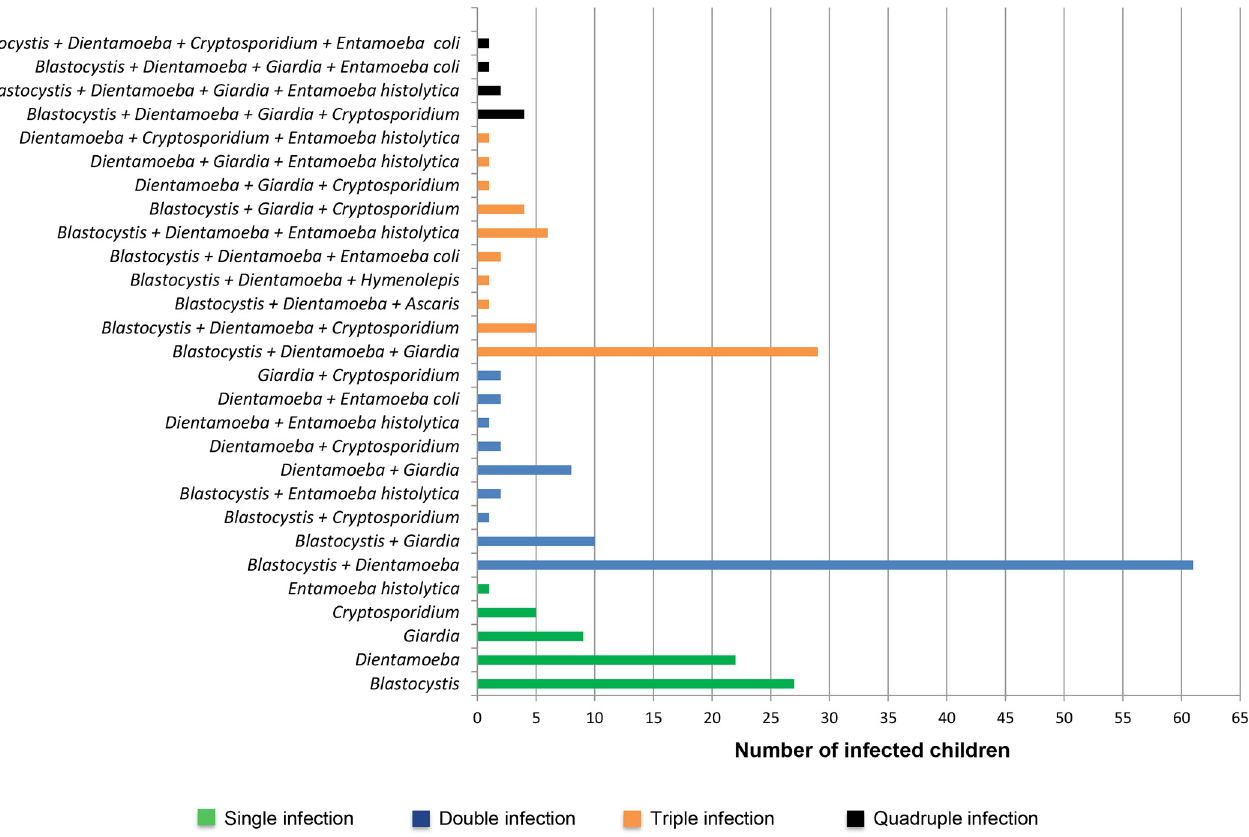
Fig 2. Distribution of single and mixed parasitic infections in schoolchildren in Tripoli. Single, double, triple and quadruple infections are shown. Prevalences of Blastocystis spp., D . fragilis , Cryptosporidium spp. and G . duodenalis are based on molecular